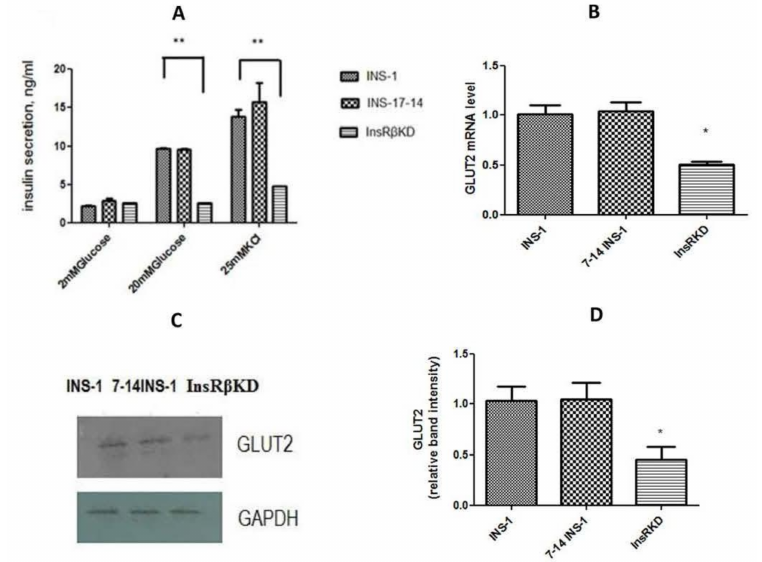
Figure 6. GSIS and GLUT2 expression in transduced cells. ( A ) ELISA results of insulin secretion induced by 2 and 20 mM glucose and 25 mM KCl in INS-1, 7-14 INS-1, and InsR β KD cells. Compared to controls, InsR β KD cells showed significantly reduced insulin secretion at 20 mM glucose and 25 mM KCl stimulations. ( B ) GLUT2 mRNA expression by qPCR analysis, which was normalized to GAPDH expression and then to that of INS-1 cells. ( C ) A representative result of Western blot analysis for GLUT2 protein expression. ( D ) The densitometry analysis of band intensity of GLUT2 relative to GAPDH. * p < 0.05, ** p < 0.01, n =